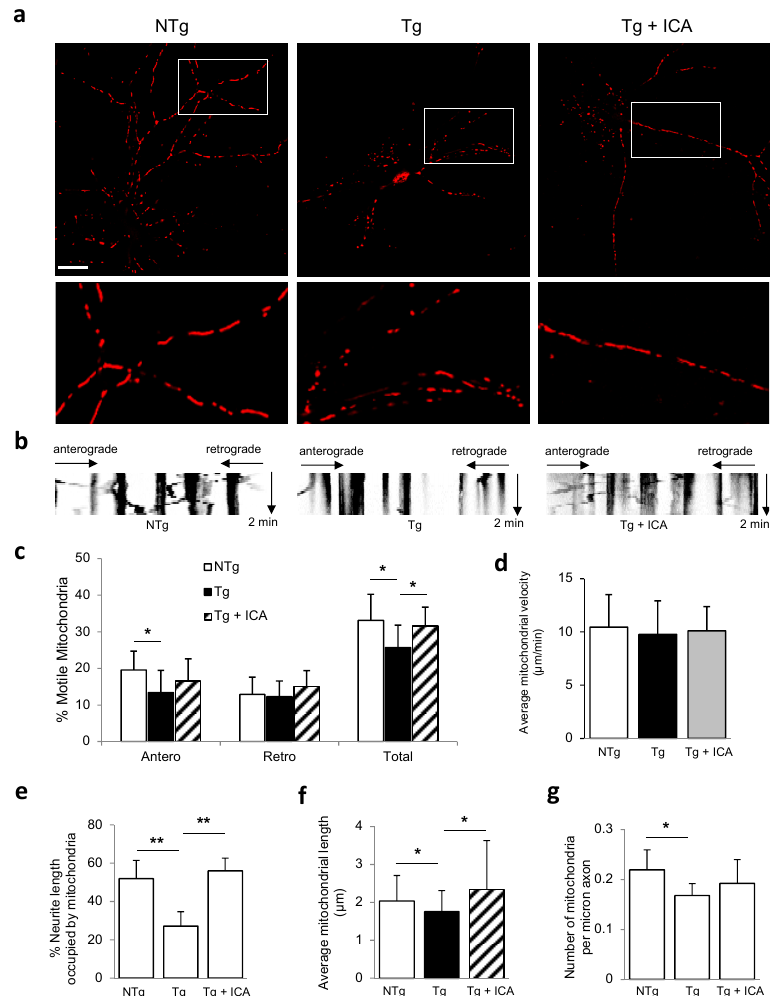
Figure 3. Effect of icariin on mitochondrial trafficking and distribution within neurites of 3× Tg-AD neurons. ( a ) DsRed-mito transfected hippocampal neurons from NTg, Tg and Tg + ICA groups were imaged. Representative images are shown in upper panels. Areas boxed in a are shown at higher magnification in the lower panels, respectively; ( b ) Representative kymograph images of the three experimental groups; ( c ) Percentages of anterograde-transported, retrograde-transported, and total movable mitochondria were calculated. Calculations were based on analysis of kymographs; ( d ) The average transport speed of movable mitochondria was calculated; ( e ) Axonal mitochondrial index (the proportion of neuritic length occupied by mitochondria) in neurons from NTg, Tg and Tg + ICA groups; ( f ) Mitochondrial length was increased in Tg neurons after icariin treatment; ( g ) Axonal mitochondrial density was evaluated as number of mitochondria per micron axon. Bar graphs (means ± SD) represented three independent experiments. * p < 0.05, ** p < 0.01. Scale bar in ( a ) = 20 μ m.